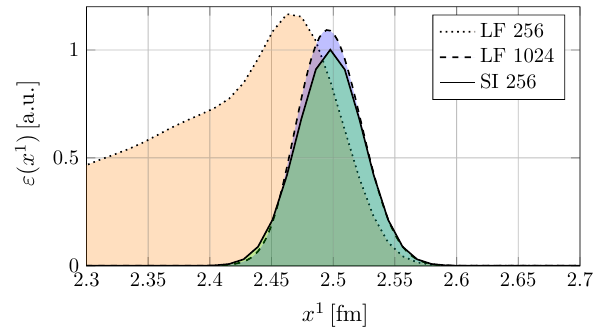
Fig. 4 The energy density of a right-moving nucleus averaged over the transverse plane as a function of the longitudinal coordinate x 1 after t = 2fm / c . The results were obtained from the same simulations as in Fig. 5. We compare the performance of the leapfrog (LF) scheme (with N L = 256 and N L = 1024) to the semi-implicit (SI) scheme with N L = 256. In the most extreme example (LF 256) the nucleus becomes completely unstable due to the numerical Cherenkov instability. By eliminatingnumericaldispersion(SI256)thenucleusretainsitsoriginal shape almost exactly